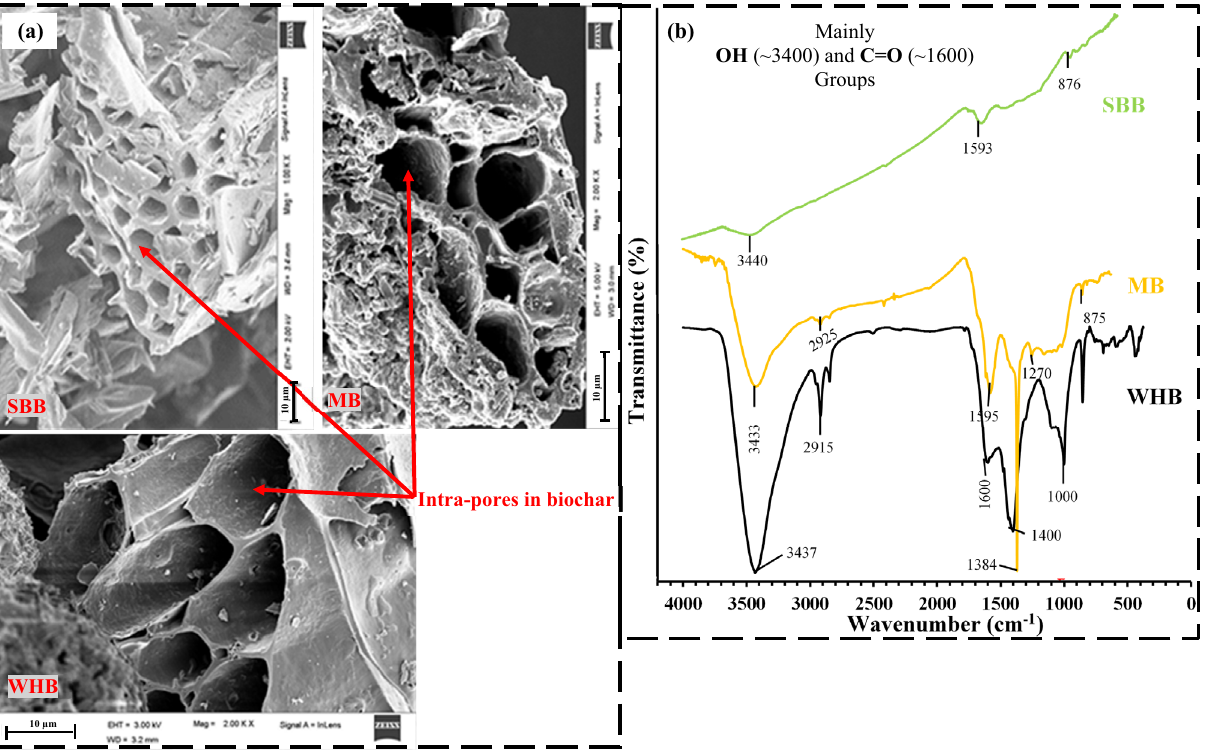
Figure 4. ( a ) FE-SEM images (at 2KX) and ( b ) FTIR spectra of different biochar